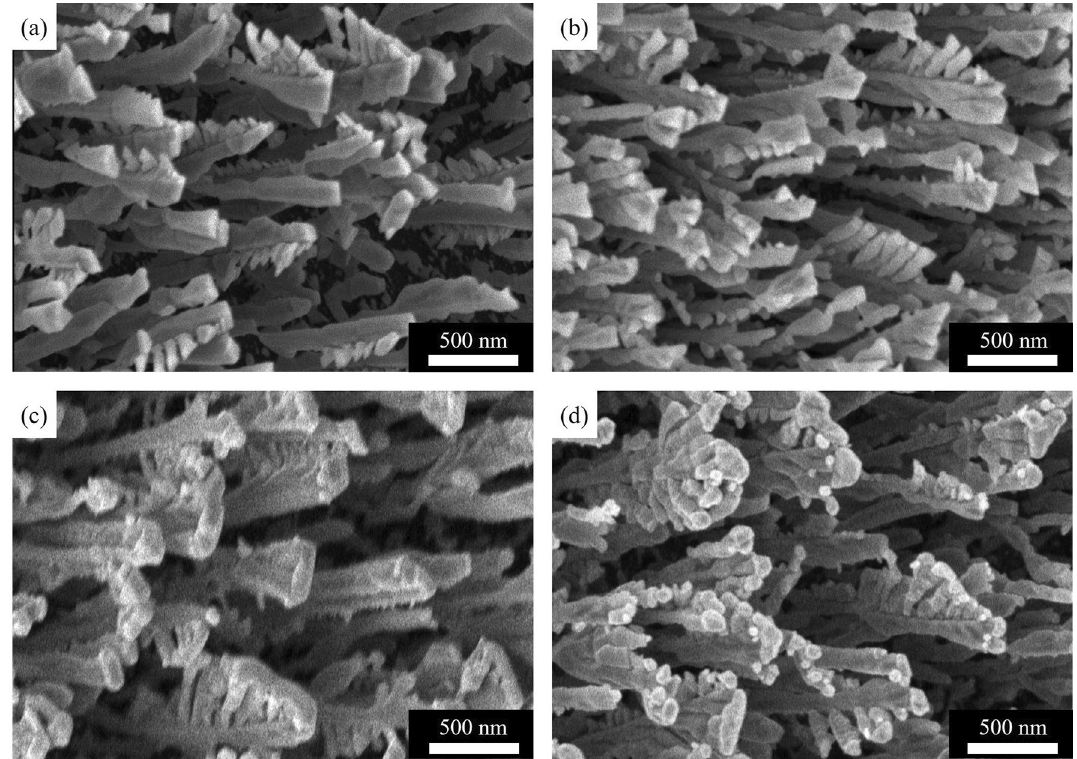
Figure 1. SEM images of Ti nanorods, ( a ) as-deposited Ti, ( b ) annealed for 4 h in an N 2 environment, ( c ) capped with 100 nm of Ag on as-deposited Ti, ( d ) capped with 100 nm of Ag on Ti annealed for 4 h in N 2